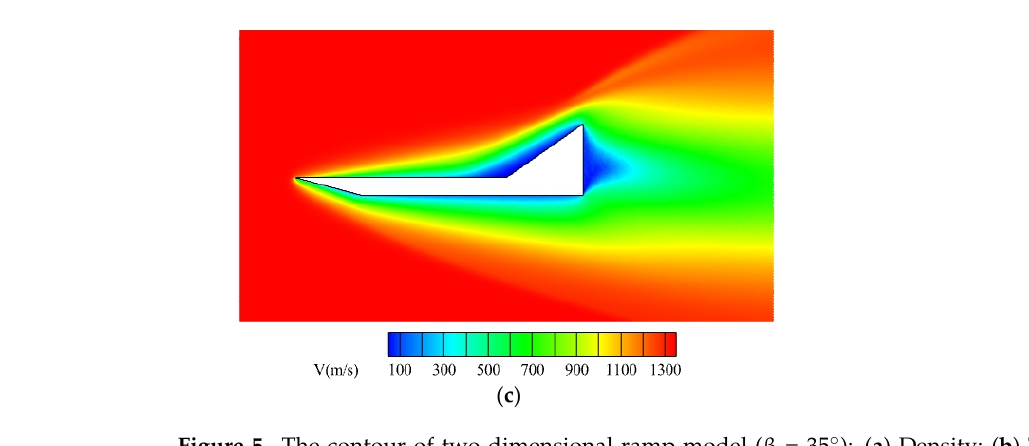
Figure 6. Wall coefficient distribution: ( a ) Friction coefficient; ( b ) Pressure coefficient.